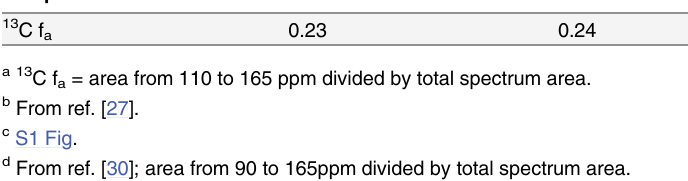
Table 2. Carbon-13 NMR aromaticities ( 13 C f a ) of untreated samples a .